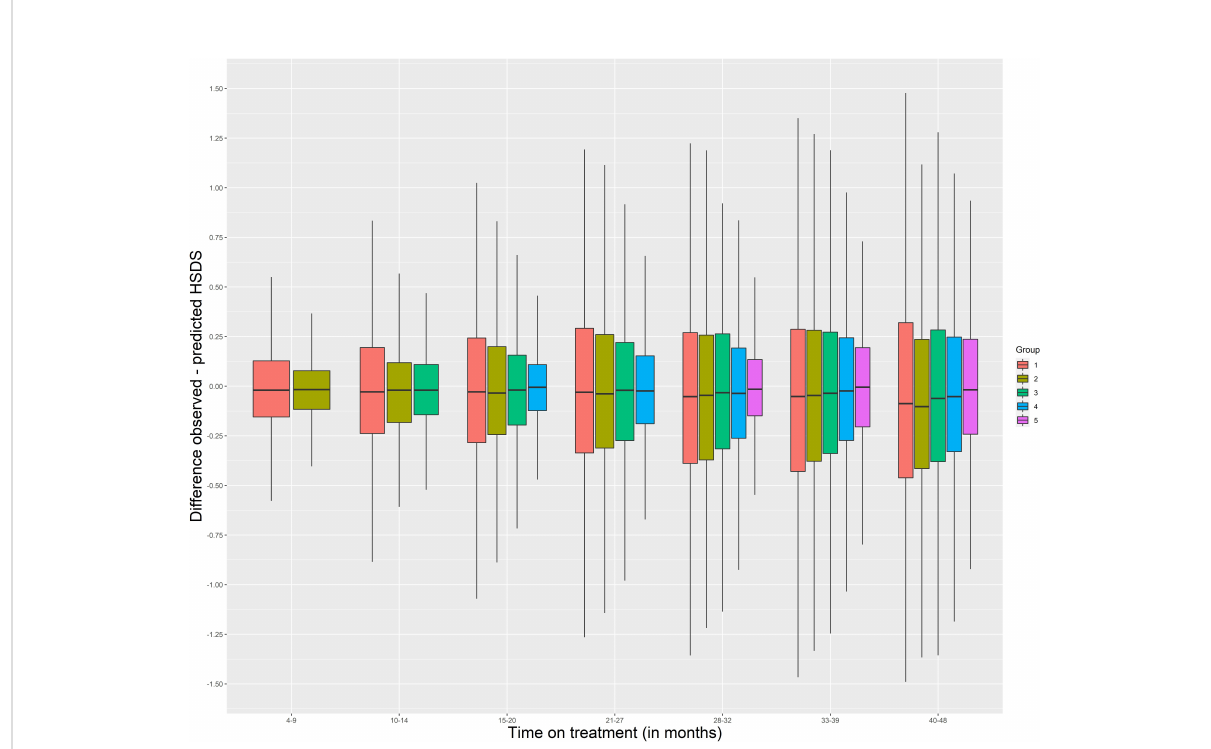
FIGURE 4 Boxplots by months on treatment using the distance between the patients ’ observed minus the predicted HSDS based on the weighted mean curves of 25 matched patients Group 1: HSDS at start known (n = 1,356) Group 2: HSDS at start known and ≥ 1 measurement between 1 – 3 months (n = 689) Group 3: HSDS at start known and ≥ 1 measurement between 4 – 6 months (n = 843) Group 4: HSDS at start known and ≥ 1 measurement between 9 – 12 months (n = 853) Group 5: HSDS at start known and ≥ 1 measurement between 7 – 12 months and between 13 – 24 months (n = 630) HSDS, height standard deviation